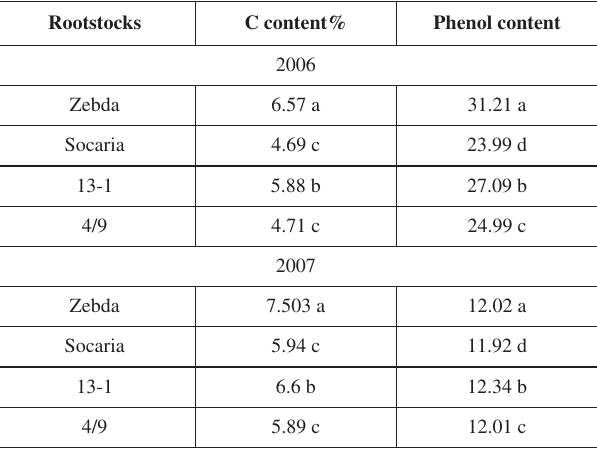
Table 4. Total carbohydrate content (%) and Phenol content (mg/100g d.wt) in leaves of the Keit mango variety as affected by grafting on the four rootstocks in 2006 and